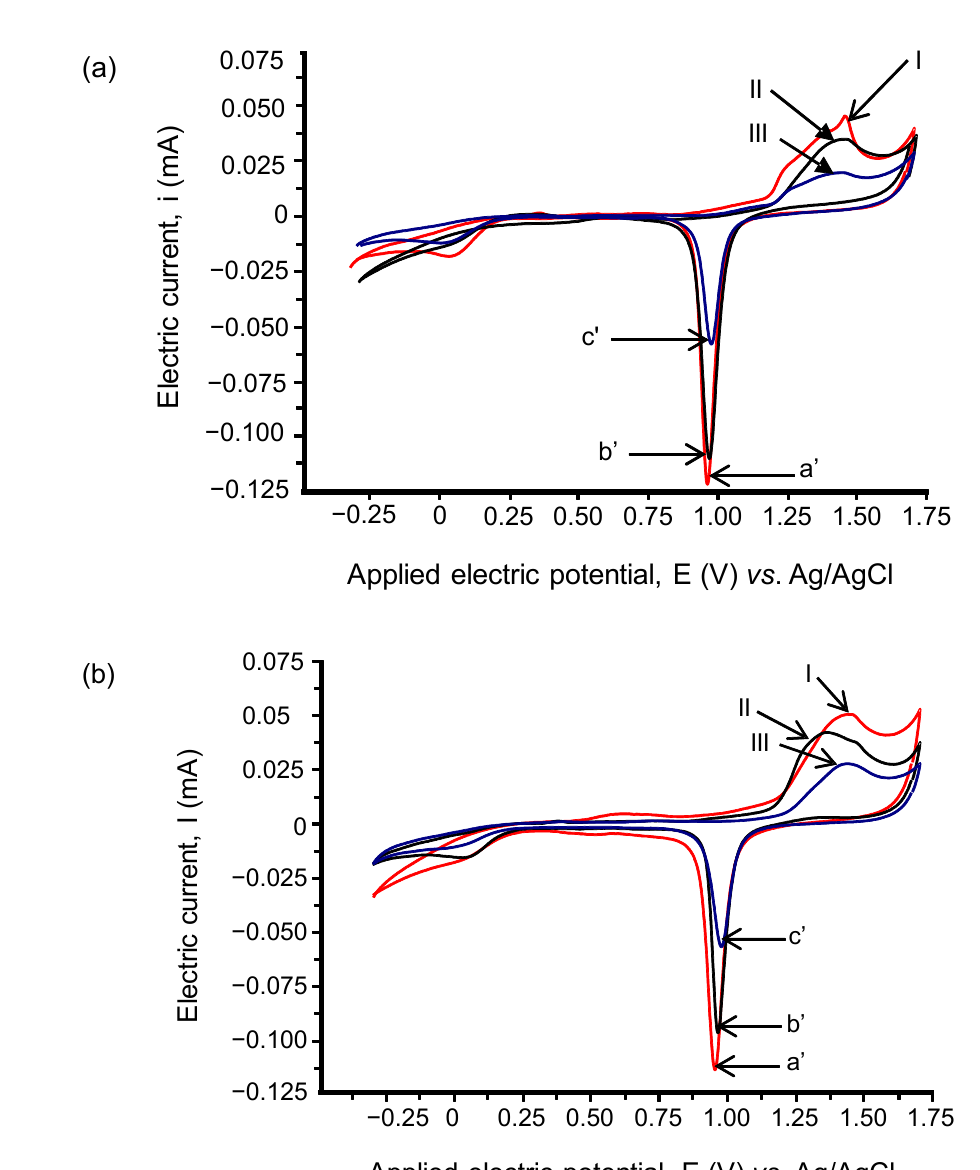
Figure 3. ( a ) Represents the reduction and oxidation peaks for: bare sensor chip, a’ and I; MCH- modified sensor chip, b’ and II; and Pty-modified sensor chip, c’ and III, respectively. ( b ) represents the reduction and oxidation peaks for: bare sensor chip, a’ and I; MCH-ssDNA-modified sensor chip, b’ and II; and Pty-ssDNA-modified sensor chip, c’ and III, respectively. The potential was swept in the range between − 0.3 and 1.7 V (vs. Ag/ AgCl) in 100 mM H 2 SO 4 , at a sweep rate of 100 mVs − 1 .